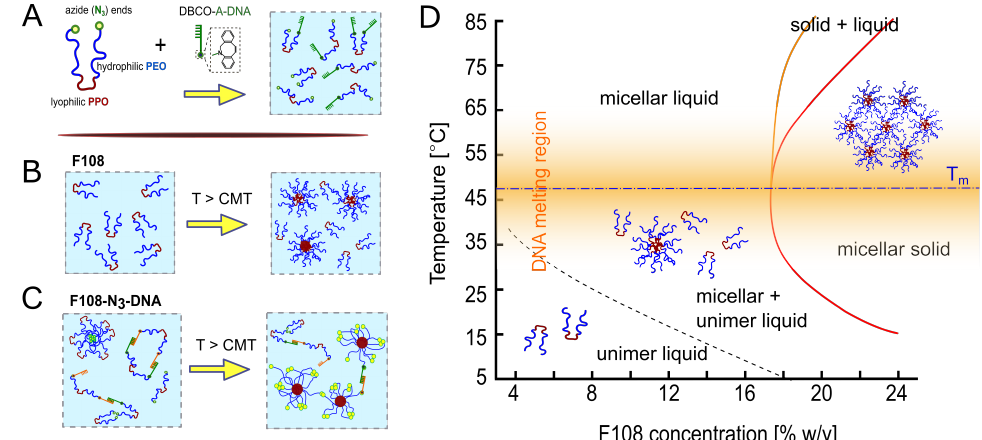
Figure 1. ( A ) Schematic of F108 with azide-functionalised PEG-ends. N 3 -groups were reacted to DBCO- A -DNA with a 10:1 molar fraction, using click-chemistry. Below the CMT, F108-N 3 - A/A (cid:48) unimers are well dispersed in water. ( B ) Non-functional F108 chains undergo a microphase separation from unimers to spherical micelles above the CMT, approximated by the dashed line. ( C ) Below the CMT, chains with complementary DNA can bind forming rings or chains while the remaining F108-N 3 -chains form transient flower micelles. Above the CMT, the unimers form standard micelles in addition to maintaining the AA (cid:48) bonds for T < T m ∼ 48 ◦ C. (dash-dotted line); the width of the DNA melting region is indicated by the orange shaded region in the phase diagram. ( D ) Experimental phase diagram of F108 in buffer solution containing 100mM NaCl, based on optical observations. The red line marks the transition to a single micellar solid phase while the region between the orange and red line indicates a micellar solid coexisting with a micellar